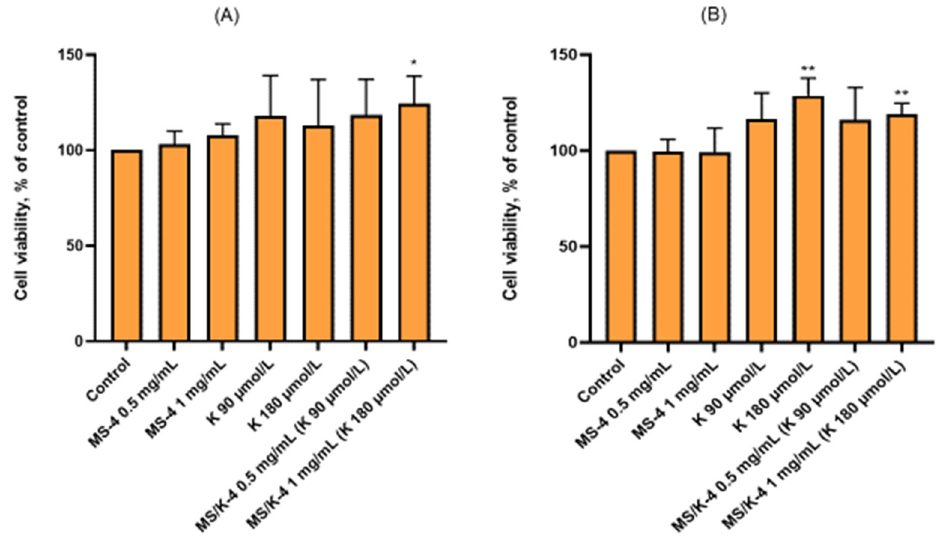
Figure 9. Effects of MS/K-4 on cell viability. ( A ) HMEC was seeded at low confluence (10,000 cells/cm 2 ) and treated after 6 h with MS/K-4, free LYS, or MS-4 for 24 h at the concentrations indicated. Cell viability was then assessed via an MTT assay and was expressed as the percent of the basal (untreated) control. Data (means ± S.D.; n = 3) were expressed as the percent of the untreated control. ( B ) HMEC was seeded at low confluence (10,000 cells/cm 2 ) in the presence of MS/K-4, LYS, or MS-4 for 24 h at the concentrations indicated. Cell viability was then assessed via an MTT assay and was expressed as the percent of the basal (untreated) control. Data (means ± S.D.; n = 3) were expressed as the percent of the untreated control. * p < 0.05 vs. basal (untreated) control; ** p < 0.01 vs. basal (untreated) control.